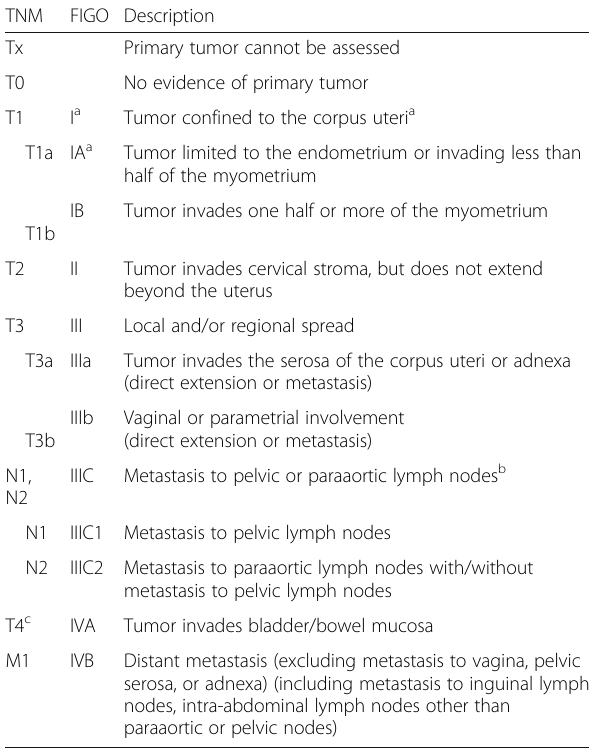
Table 1 TNM (8th Edition) and FIGO (2009) Classification of endometrial cancer (from refs. [30,